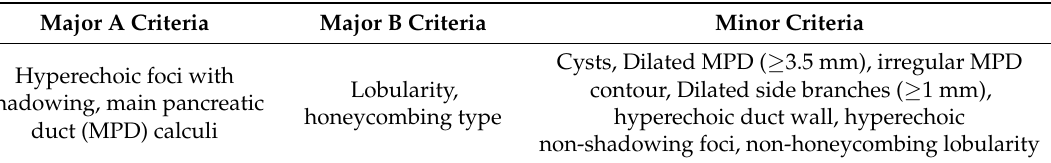
Table 3. Diagnostic EUS criteria for chronic pancreatitis [32].